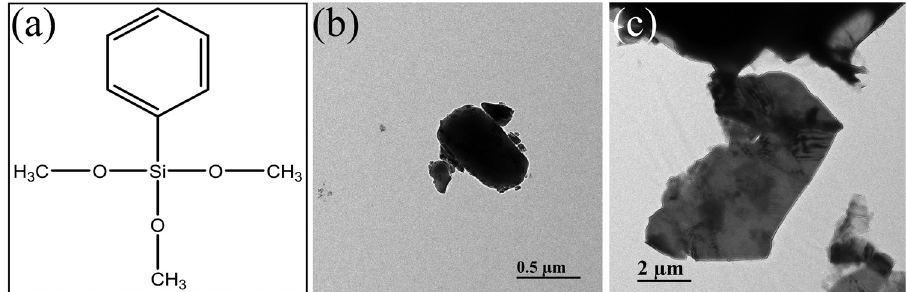
Figure 1: Molecular structure formula of A153 ( a ) ; the TEM diagrams of Al 2 O 3 ( b ) , and EG ( c ) .